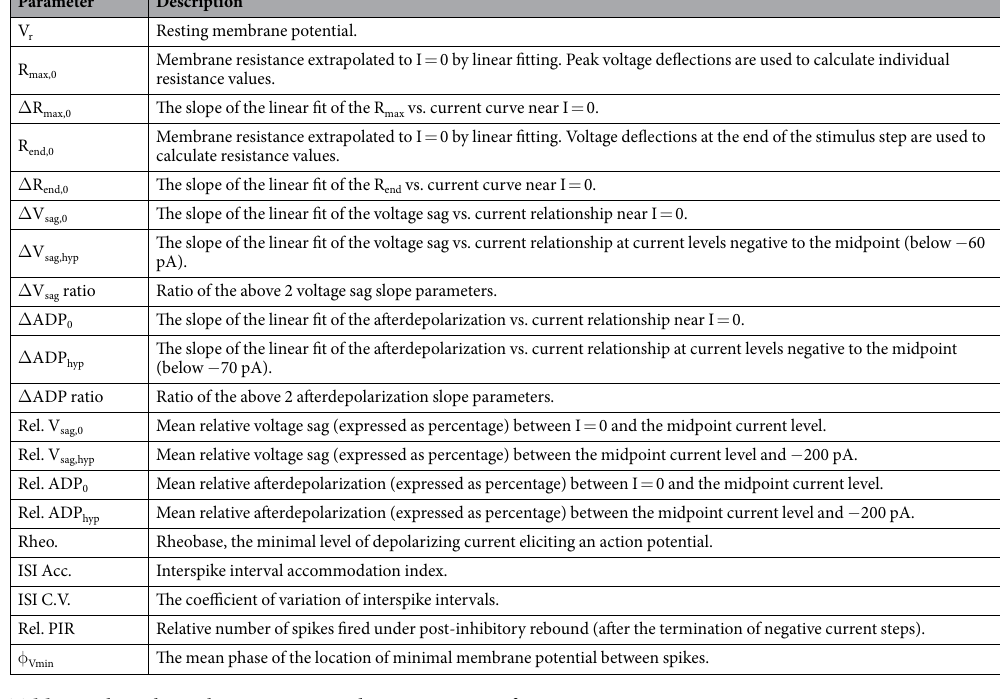
Table 1. Physiological parameters used to construct IV feature